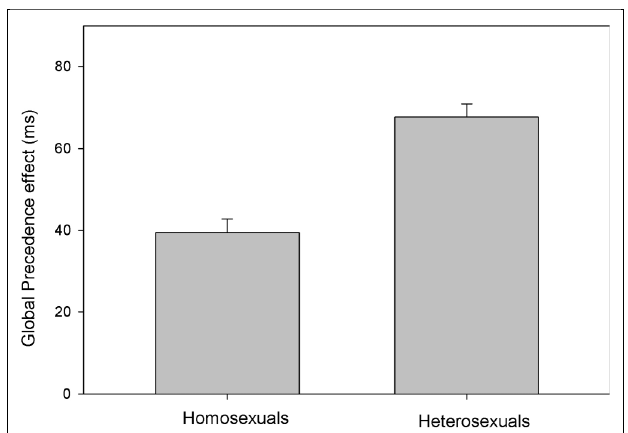
FIGURE 1 | Mean global precedence effect for homosexuals and heterosexuals. Vertical capped lines atop bars indicate standard error of the